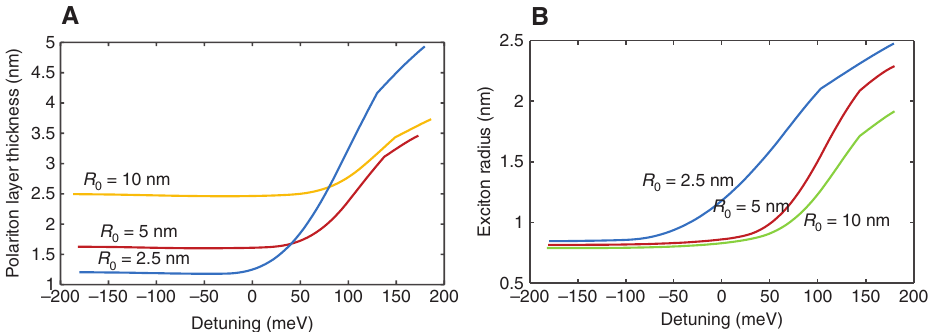
Figure 7: (A) Lower polariton shell thickness d and (B) excitonic radius a versus the energy of the “undressed” surface plasmon relative to the bandgap energy for three different radii of the Ag nanosphere. The free exciton radius is equal to 2.8